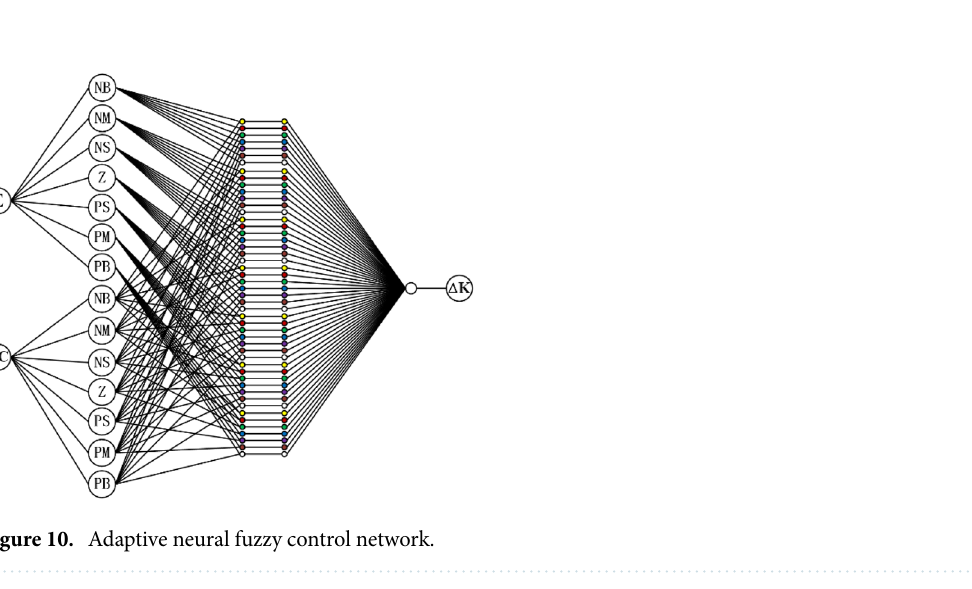
Figure 9. Output surfaces of the coefficients for fuzzy PID controller.